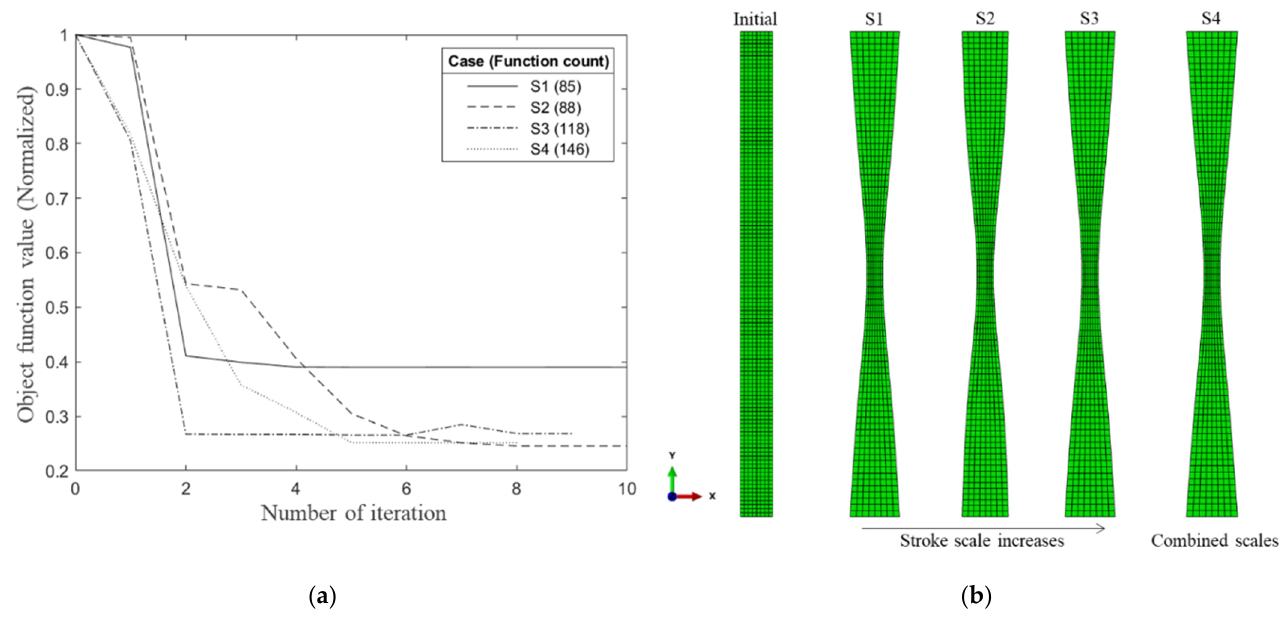
Figure 6. Static optimization results: ( a ) Optimization history curves of cases S1–S4; ( b ) Optimized shapes with static analysis (S1–S4). Table 1. Shape variable values, energy dissipation, and improvement of each optimized model with a fixed